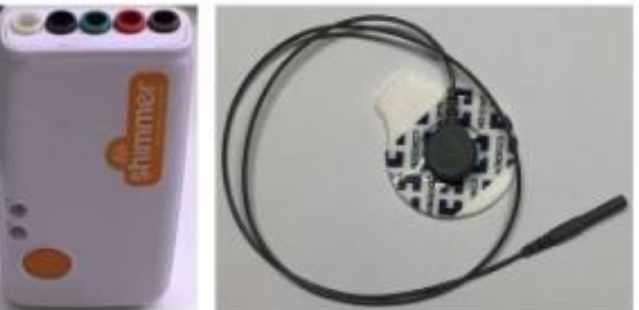
Figure 5. SHIMMER3 EXG Unit SR47-4-0, Covidien ECG electrode, and SHIMMER snap lead for ECG recordings.